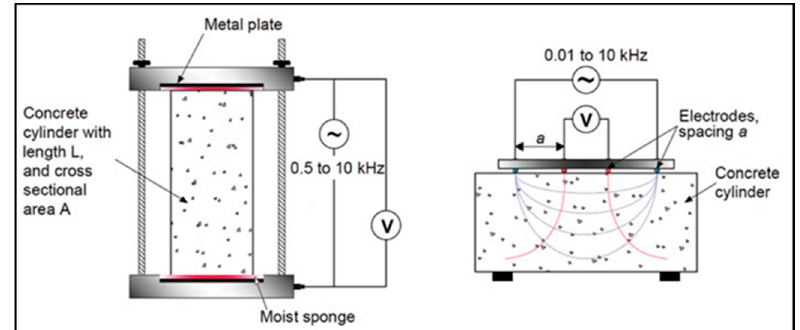
Figure 4. Typical electric resistivity setup, image sourced from [49].